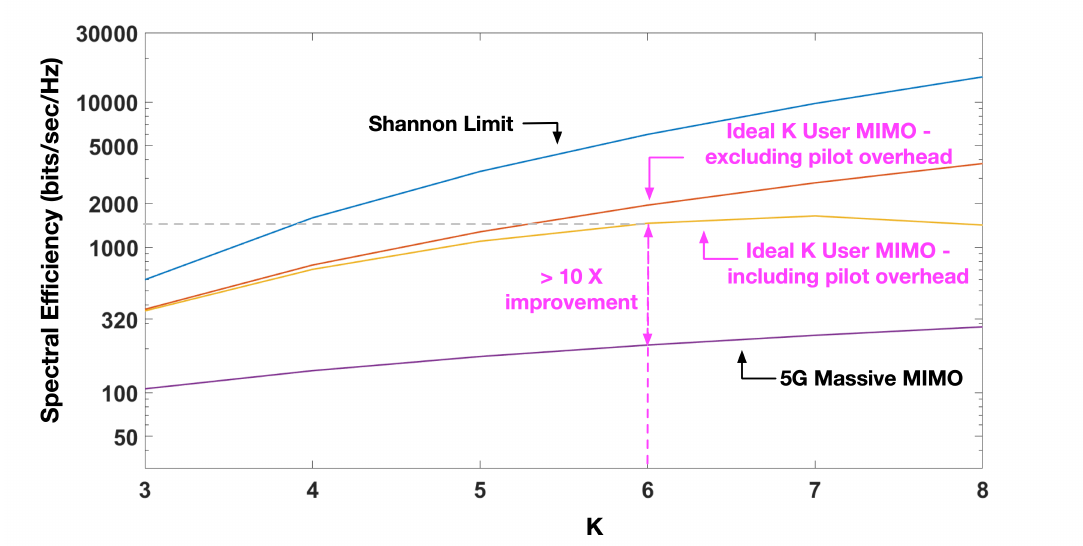
Figure 4. Comparison of our very high throughput K -User MIMO X spectral efficiencies against related technologies such as 5G-NR Massive MIMO. Spectral Efficiencies are for a 100 m cell in an Indoor A channel scenario. The curve for Massive MIMO is based on the formula shown in [23]. The number of antennas is M = K ( K − 1 )